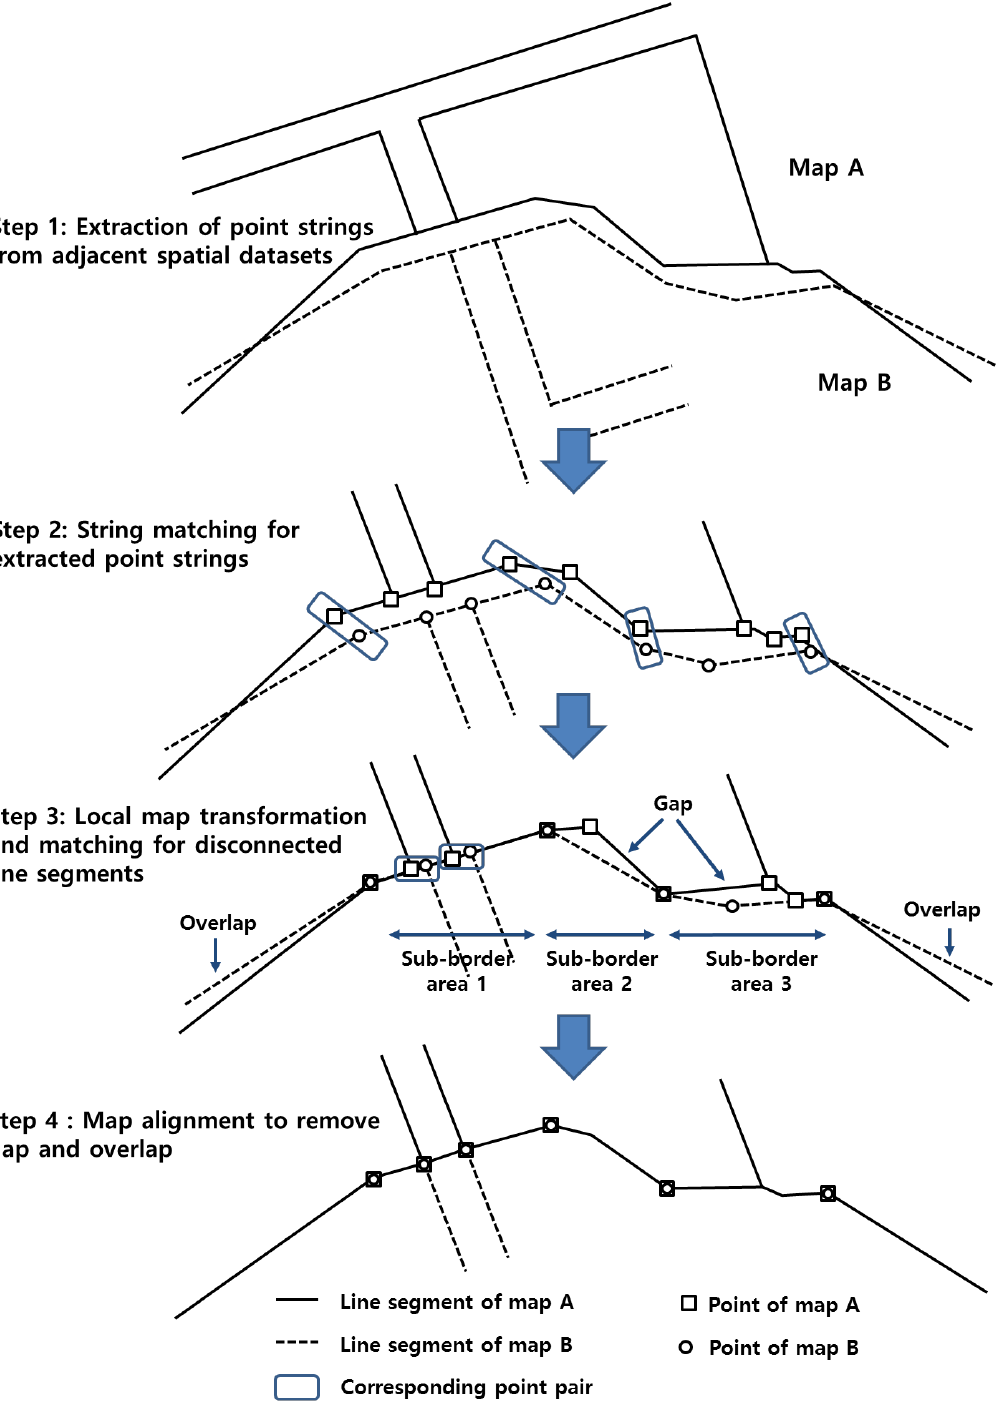
Figure 2. Workflow of the proposed